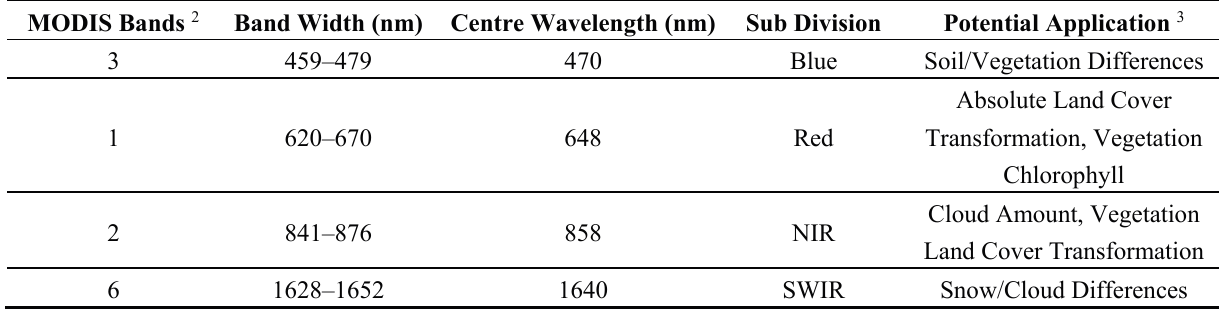
Table 2. Specifics of the MODIS-Terra bands (MOD09A1) used in this study 1